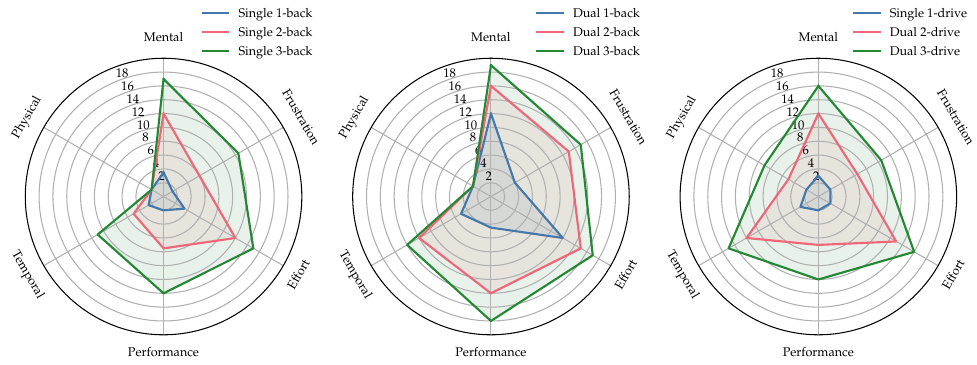
Figure 9. The three plots summarize the NASA-TLX answers of all six dimensions as the mean over all subjects. From left to right: Mean answers during single n -back, dual n -back and k -drive tasks. Reported numbers are not weighted and reflect the raw task load index described in Section 2.6. This radar visualization shows that mental, frustration, effort, performance and temporal dimensions increase with cognitive load tasks of higher intensities ( n 1,2,3 -back) and dual vs. single, while ∈ { } the change in the subjectively perceived physical load is, compared to these dimensions, smaller. For k -drive of dual and single tasks, every NASA-RTLX dimension increases with a higher CL.